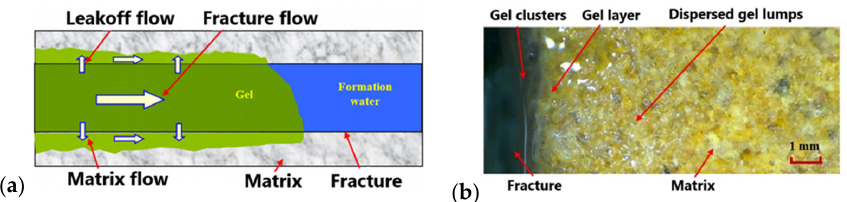
Figure 19. Simulation and example of flow behaviors of gelants in fractures: ( a ) migration and flow of gelants in fractures and matrices; ( b ) overall distribution pattern of polymer gels in fractures and matrices after gelation. (Reprinted/adapted with permission from Ref. [21], 2020, Zhang et al.).